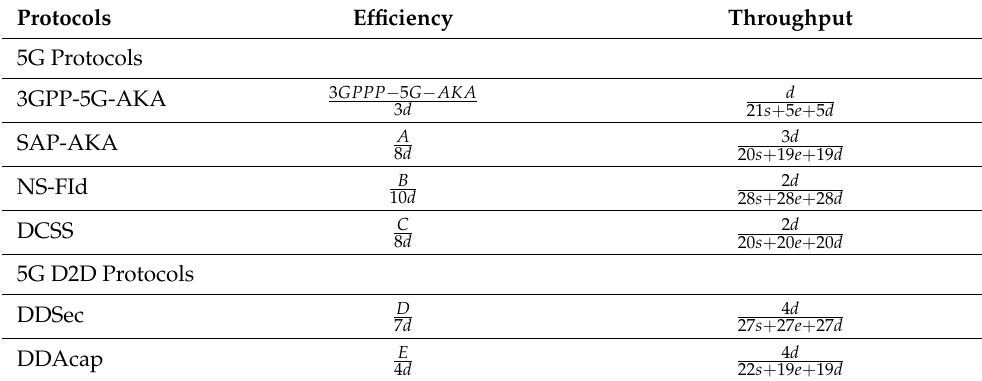
Table 4. Protocols Performance Evaluation.